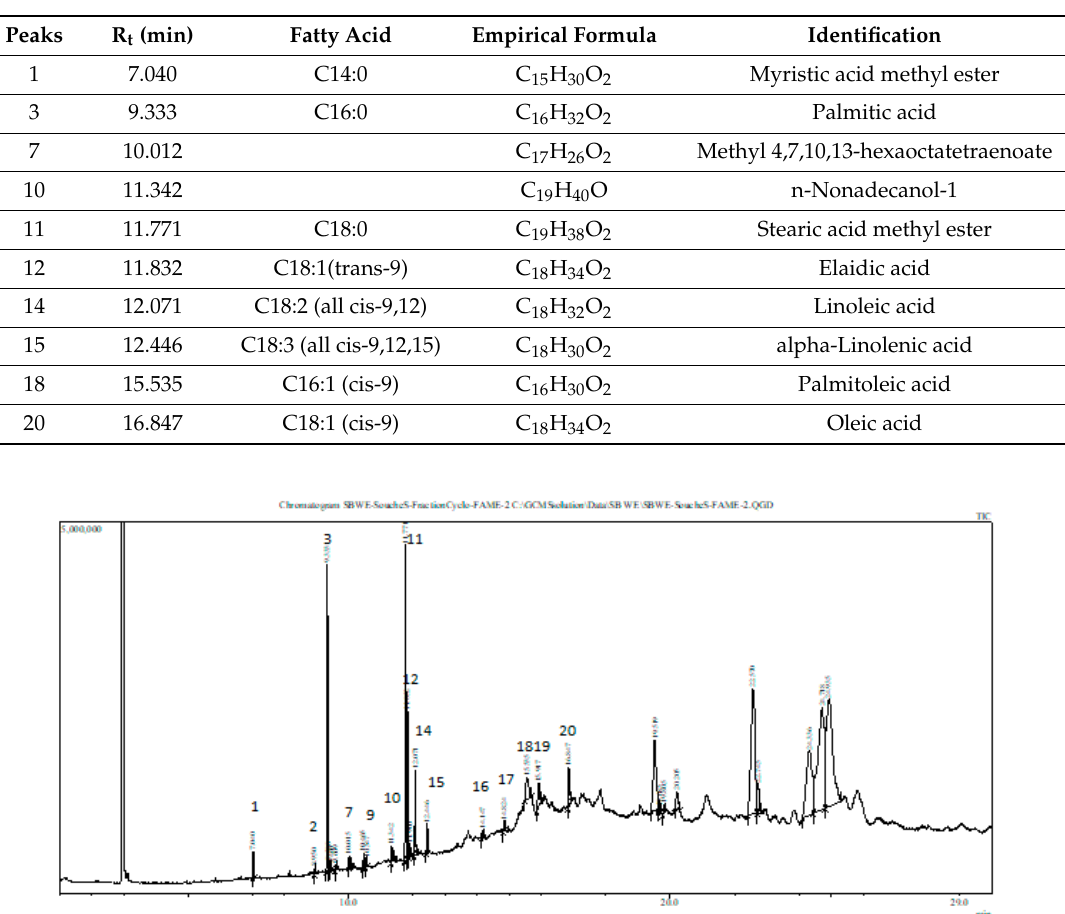
Figure 4. GC–MS profile of the salt-stressed Scenedesmus sp. (Ss10) extract. The peak assignments are listed in Table 4. Table 4. Fatty acid composition of FAMEs of salt-stressed Scenedesmus sp. (Ss10) acquired by GC– MS.